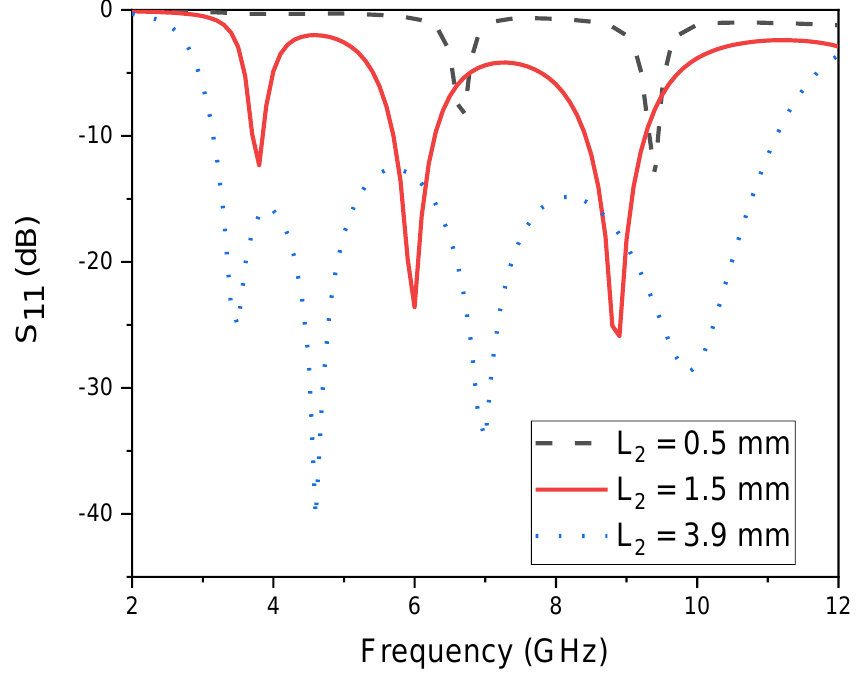
Figure 8. Transmission poles appearance w.r.t parameter L 2 .